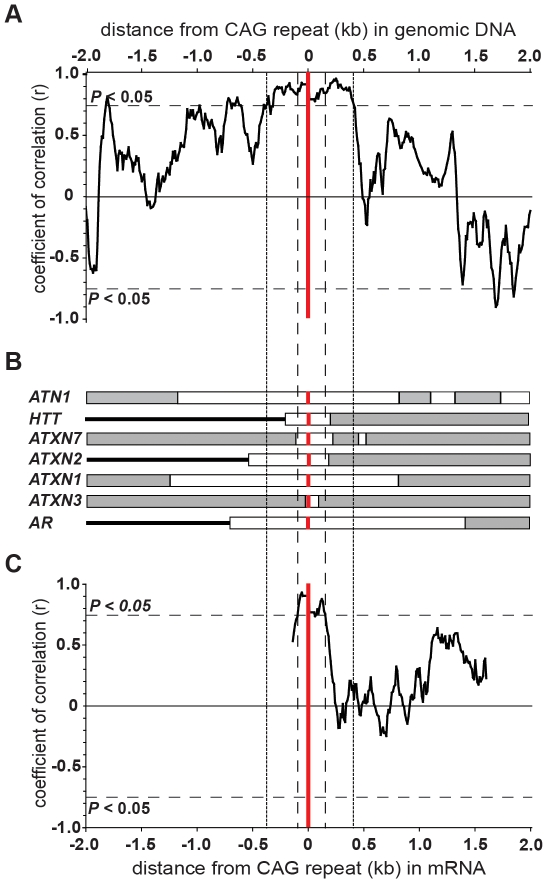
Inter-locus polyQ toxicity correlates with the flanking genomic DNA sequence GC content, but does not extend beyond the repeat containing exon in the mRNA sequence.(A) Inter-locus polyQ toxicity correlates with the flanking genomic DNA sequence GC content. The graph shows the coefficient of correlation (r) for the relationship between inter-locus polyQ loci toxicity and flanking genomic DNA sequence GC content. GC content was sampled using a sliding window of 100 bp and a step size of 10 bp. The threshold for statistical significance (dashed lines) and the position of the CAG•CTG repeat (red vertical bar) are also shown. Note that the region of statistically significant correlation extends for ∼400 bp either side of the repeat tract (as indicated by the vertical dotted lines). (B) Gene structure of the seven polyQ containing genes. All diagrams are to scale. Exons (white box), introns (grey box), intergenic regions (horizontal black bar), and repeat tract (vertical black bar) are shown. (C) Inter-locus polyQ toxicity only correlates with flanking mRNA sequence GC content to the 5′ and 3′ ends of their host exons. The graph shows the coefficient of correlation (r) for the relationship between inter-locus polyQ toxicity and flanking mRNA sequence GC content determined as in (A). Note that the region of statistically significant correlation extends for only ∼100 bp either side of the repeat tract (as indicated by the vertical dashed lines) corresponding to the length of mRNA sequence encoded by the repeat containing exons and not extending into flanking exons.